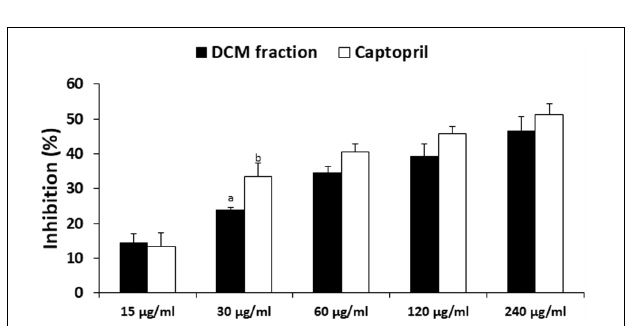
FIGURE 8 | Angiotensin 1 converting enzyme (ACE) inhibitory activity of DCM fraction of C. volubile methanolic extract. Data = mean ± SD ; ab Values are significantly ( p < 0.05) different from each other.